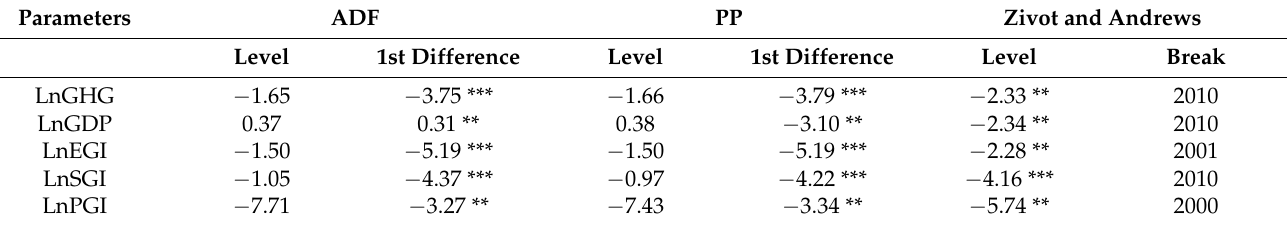
Table 2. Results of unit root test.